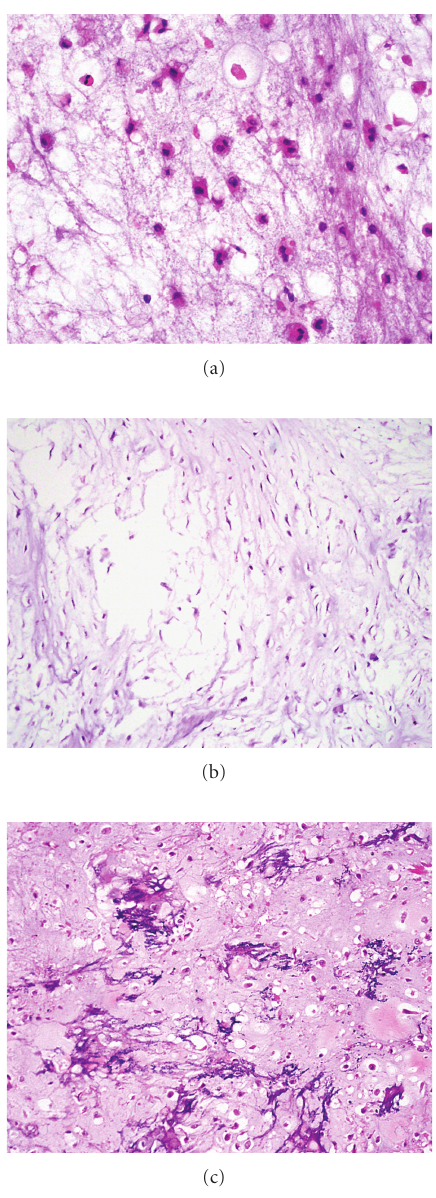
Figure 3: (a) Atypical chondrocytes with binucleation and eosinophilic cytoplasm; (b) chondrosarcoma with myxoid change; (c) chondrosarcoma with necrotic tumor cells and